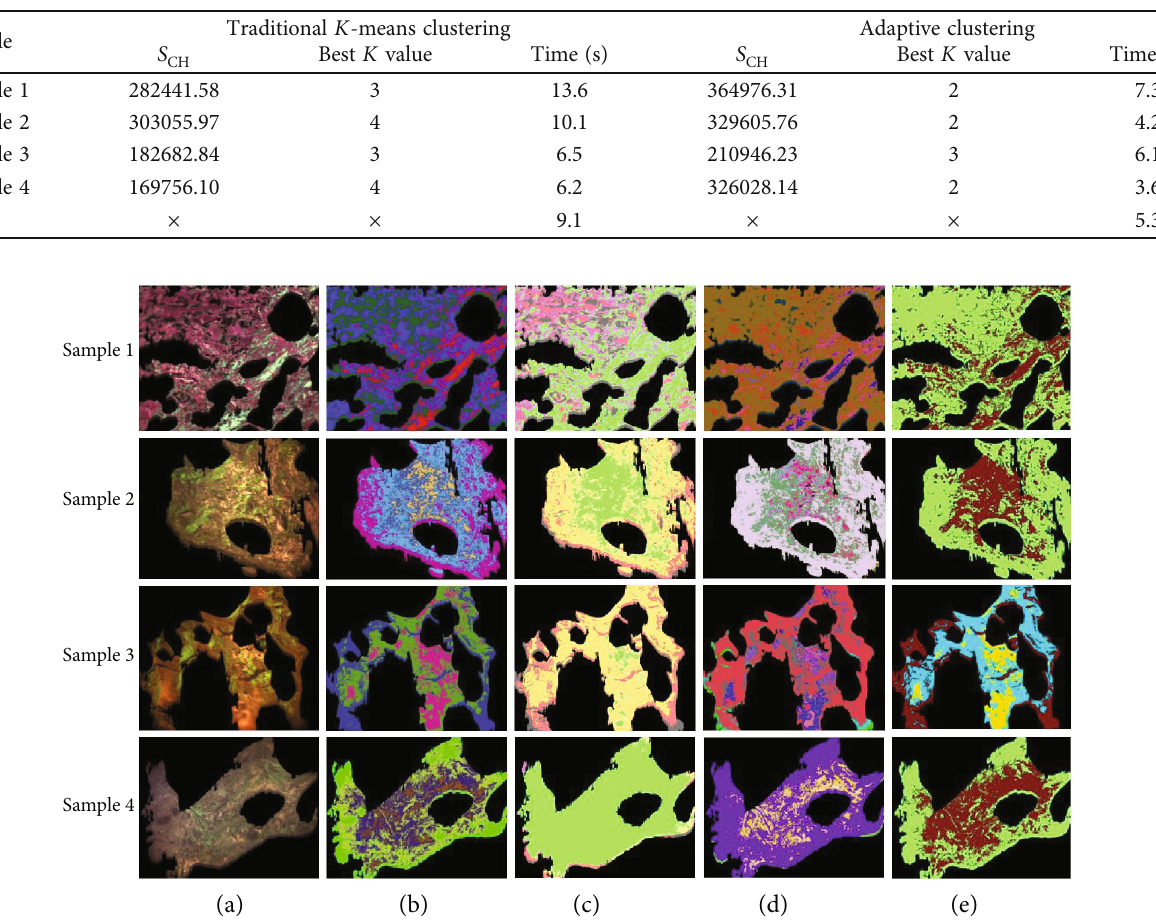
Table 3: Comparison of cluster-related parameters before and after